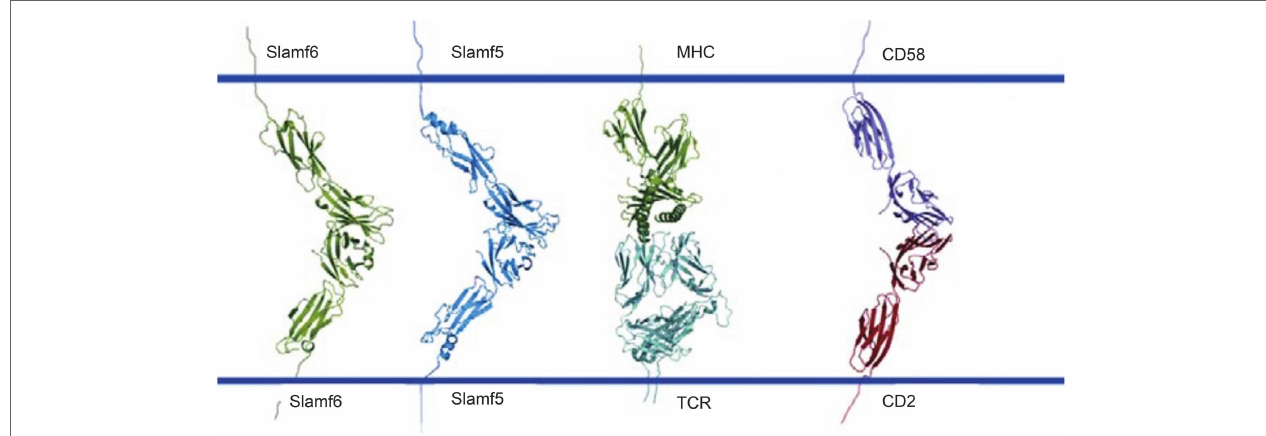
FiGURe 2 | Ribbon representation of Slamf6 and Slamf5 structures. Homophilic interactions of SLAMF6 and SLAMF5 as well as heterophilic interactions between two other Ig-superfamily receptors CD58 and CD2. MHC interacting with TCR functions as a reference for the molecular dimensions. Image adopted from Calpe et al.